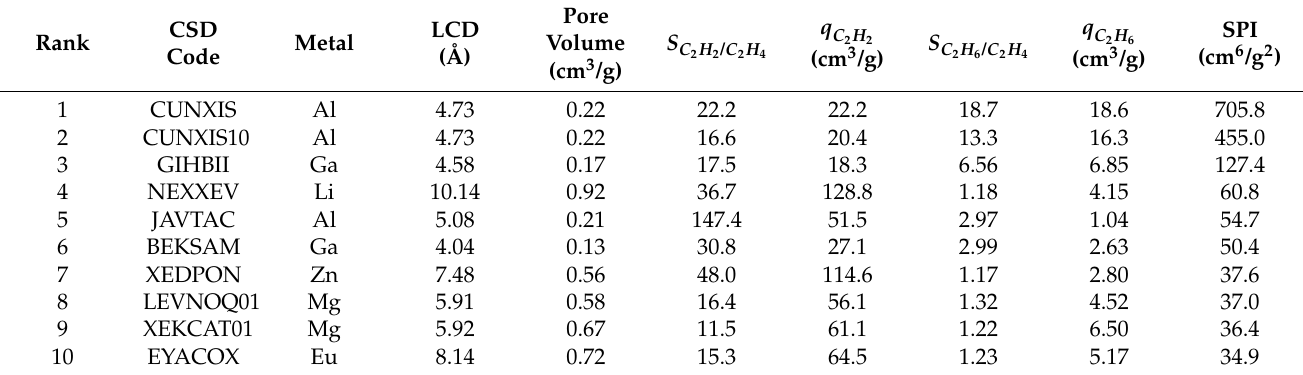
Table 3. Structural properties, selectivity, capacity, and SPI of the top 10 MOF candidates for the single-step separation of C 2 H 2 /C 2 H 4 /C 2 H 6